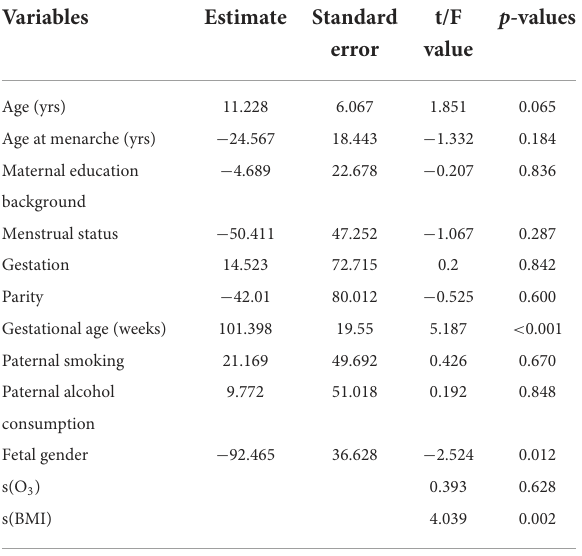
TABLE 3 Generalized additive model based on O 3 and demographic variables associated with birth weight ( N = 407) a .